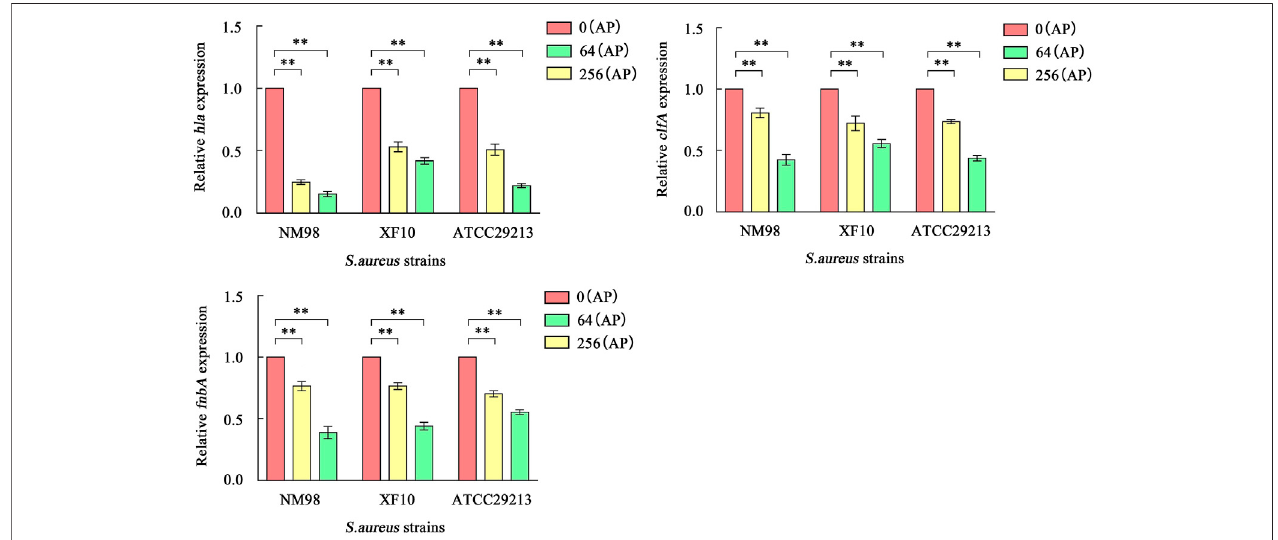
FIGURE 6 | Effect of AP on hla, clfA, and fnbA transcription. Note: NM98, XF10, and ATCC29213 denote different S. aureus strains; 0 (AP), 64 (AP), and 256 (AP) denote 0, 64, and 256 μ g/ml of AP, respectively; ** p < 0.01 compared with the control.